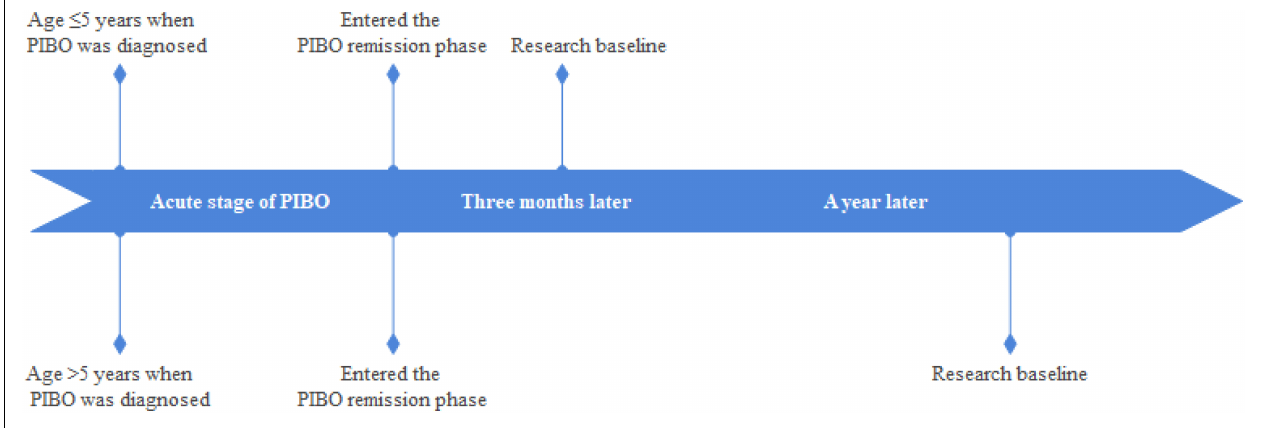
FIGURE 1 | Flow chart of the setting of the research baseline.